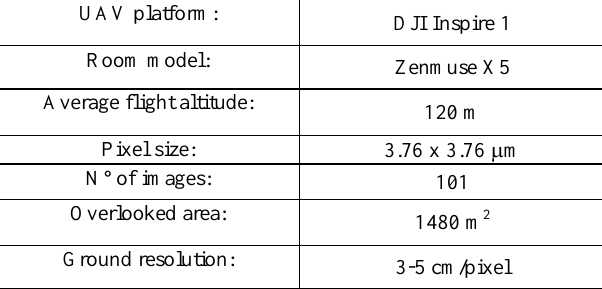
Table 3. Characteristics of the flight